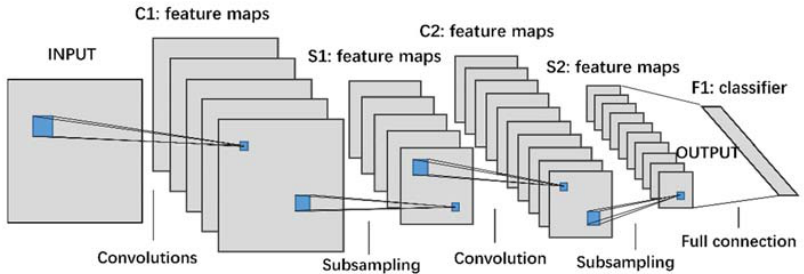
Figure 5. Structure of a CNN.